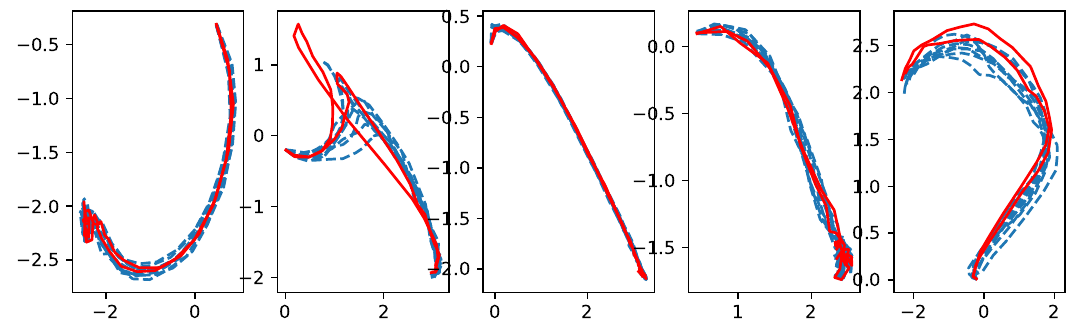
Figure 12. Cross-validation results for the beginner’s skills (from left to right): Forehand stroke, forehand drive, forehand cut, backhand drive, backhand